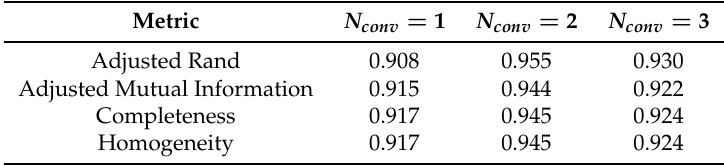
Table 4. Best metric scores for different convolutional